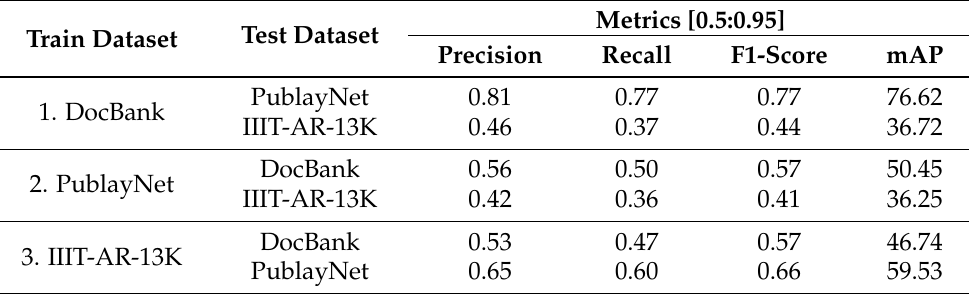
Table 8. The cross-validation results using Leave-One-Out strategy on DocBank, PublayNet, and IIIT- AR-13K. All results are obtained from the model with Faster-RCNN+ConvNeXt+DyHead. Similarities between the DocBank and PublayNet data evidently help the model detect objects with better performance as opposed to IIIT-AR-13K. Furthermore, due to anomalies in DocBank, as compared to the clean annotations in PublayNet, training with PublayNet and testing with DocBank yields poor results compared to the opposite scenario, i.e., training on DocBank and testing on PublayNet.